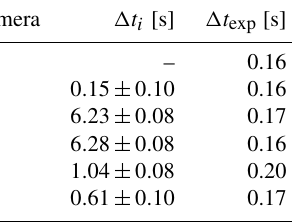
Table A2. Relative differences in recorded (system) time stamps and exposure times (at